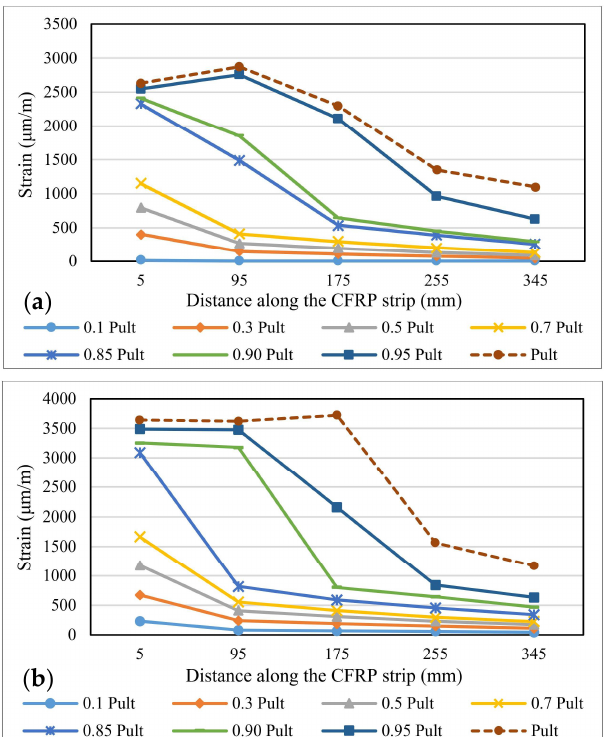
Figure 10. Strains distribution along the bond length for specimens: ( a ) S-S512-30-2-I and ( b ) S-M514-30-1-II.